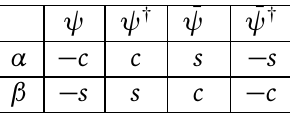
Table 1: Parameters of the vertex operators (42) for the fermionic